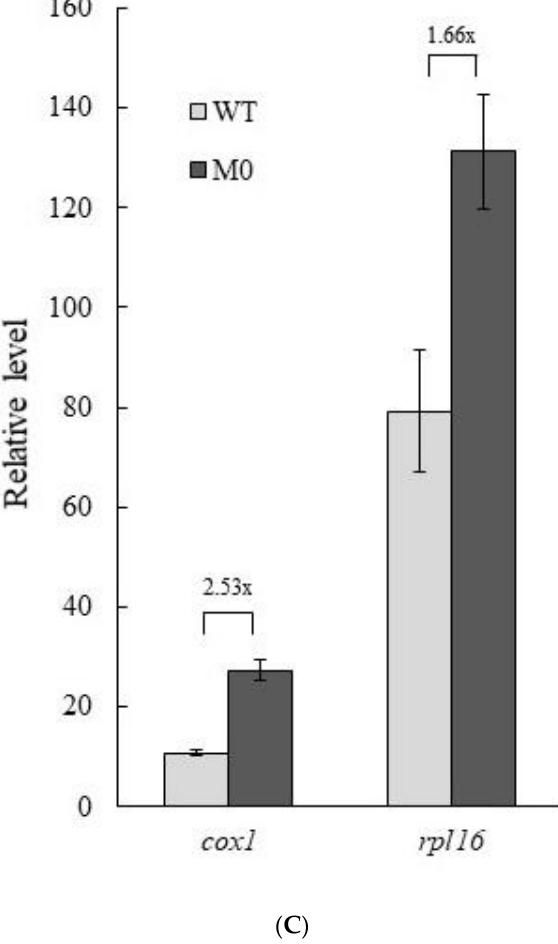
Figure 2. The relative copy numbers of mitochondrial DNA in transgenic tobacco lines. ( A ). The DNA-Seq reads from transgenic M0, M8, M17, M29 and untransformed TN90 plants were mapped to the mtDNA template (NC_006581) by the CLC Genomic Workbench 10 with the most stringent parameters of L = 1.0 and S = 1.0 (Supplementary Table S4). The relative average coverage of bulk mtDNA in transgenic (M8, M0, M17 and M29) and untransformed TN90 plants is shown by the normalization of the average coverage of each mtDNA to that of the nuclear EF-1 α gene in the corresponding plants. ( B ). The relative average coverage of the mitochondrial cox1 and rpl16 genes in transgenic (M8, M0, M17 and M29) and untransformed TN90 plants is shown by the normalization of the average coverage of each gene to that of the nuclear EF-1 α gene in the corresponding plants. ( C ). The relative copy number of mitochondrial genes was estimated by a qPCR assay in PEP-deficient (M0) tobacco and wild-type (WT) plants. Total DNA was isolated from the leaf tissues of M0 plants (dark grey) and WT tobacco (light grey) grown in half-strength MS media. The relative copy numbers of the mitochondrial cox1 and rpl16 genes were estimated by qPCR with nuclear EF-1 α as a control. The qPCR assay was carried out in triplicate. Data are means ±